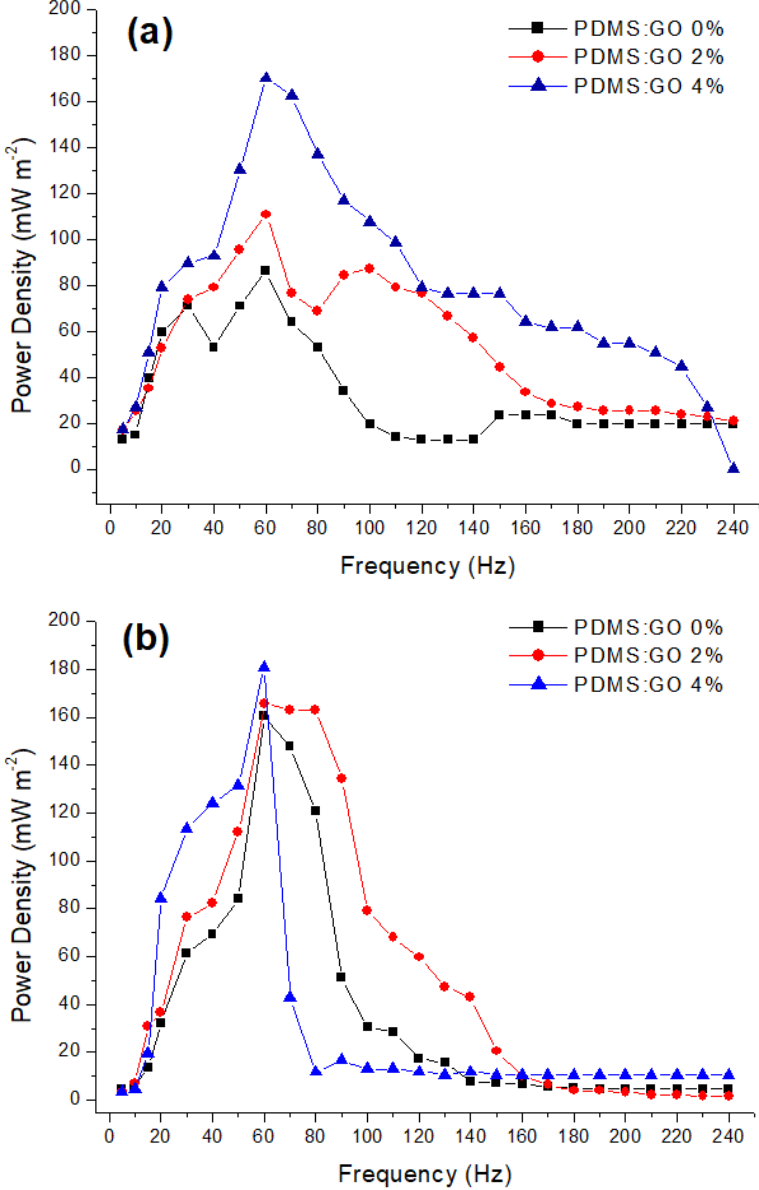
Figure 6. Power density versus frequency for TENGs assembled with different configurations: ( a ) TENG without a steel spring material; ( b ) device containing a steel